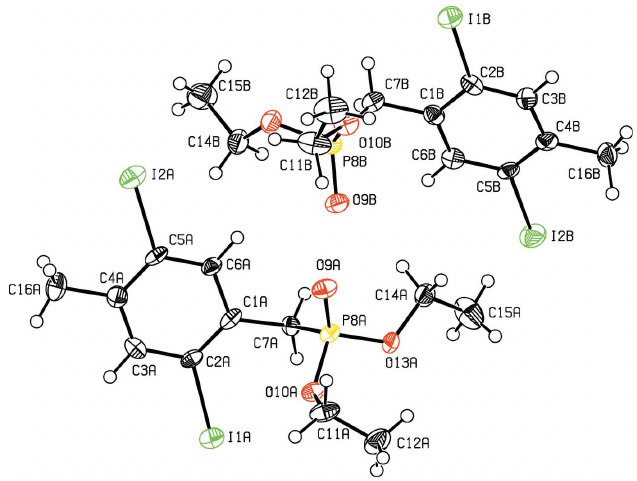
Figure 1 View of the two independent molecules in the title compound. Displacement ellipsoids are drawn at the 50% probability level.